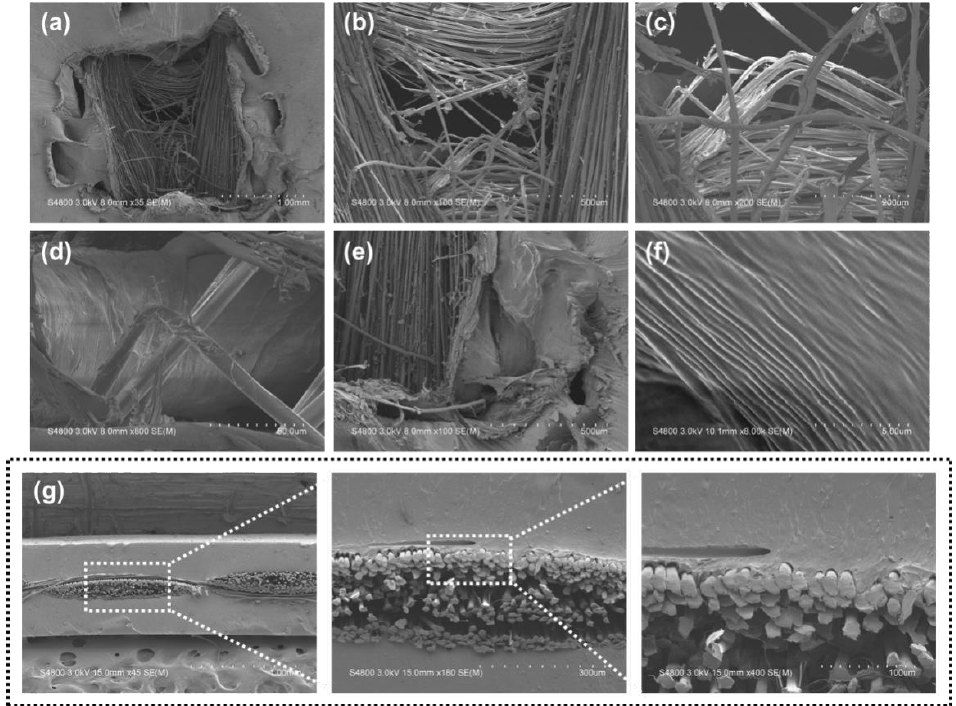
Figure 11. ( a ) SEM photos of Kevlar/TPU laminated composites after the puncture, ( b – d ) the position after the fiber is damaged, ( e , f ) the position after the sheet is damaged, ( g ) section photo of laminated composites.